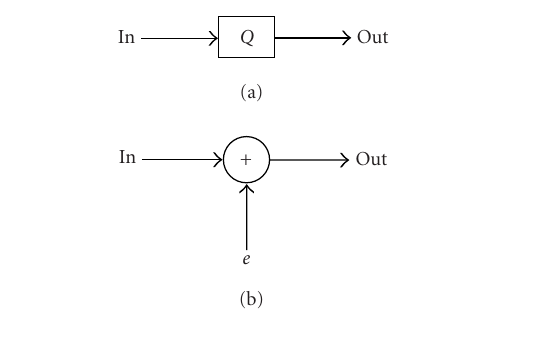
Figure 6: Signal flow graph of (a) the truncation of a datapath wordlength and (b) the truncation of a datapath wordlength mod- eling quantization with the noise source